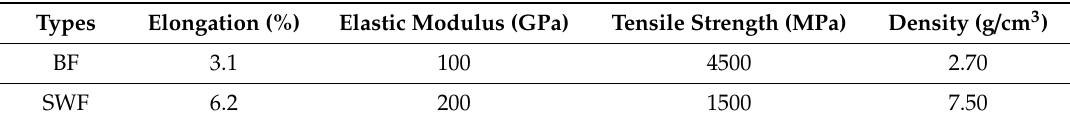
Figure 2. Two kinds of fibers used in asphalt mortar ( a ) basalt fiber (BF) and ( b ) steel wool fiber (SWF). Table 2. Material properties of the fibers.